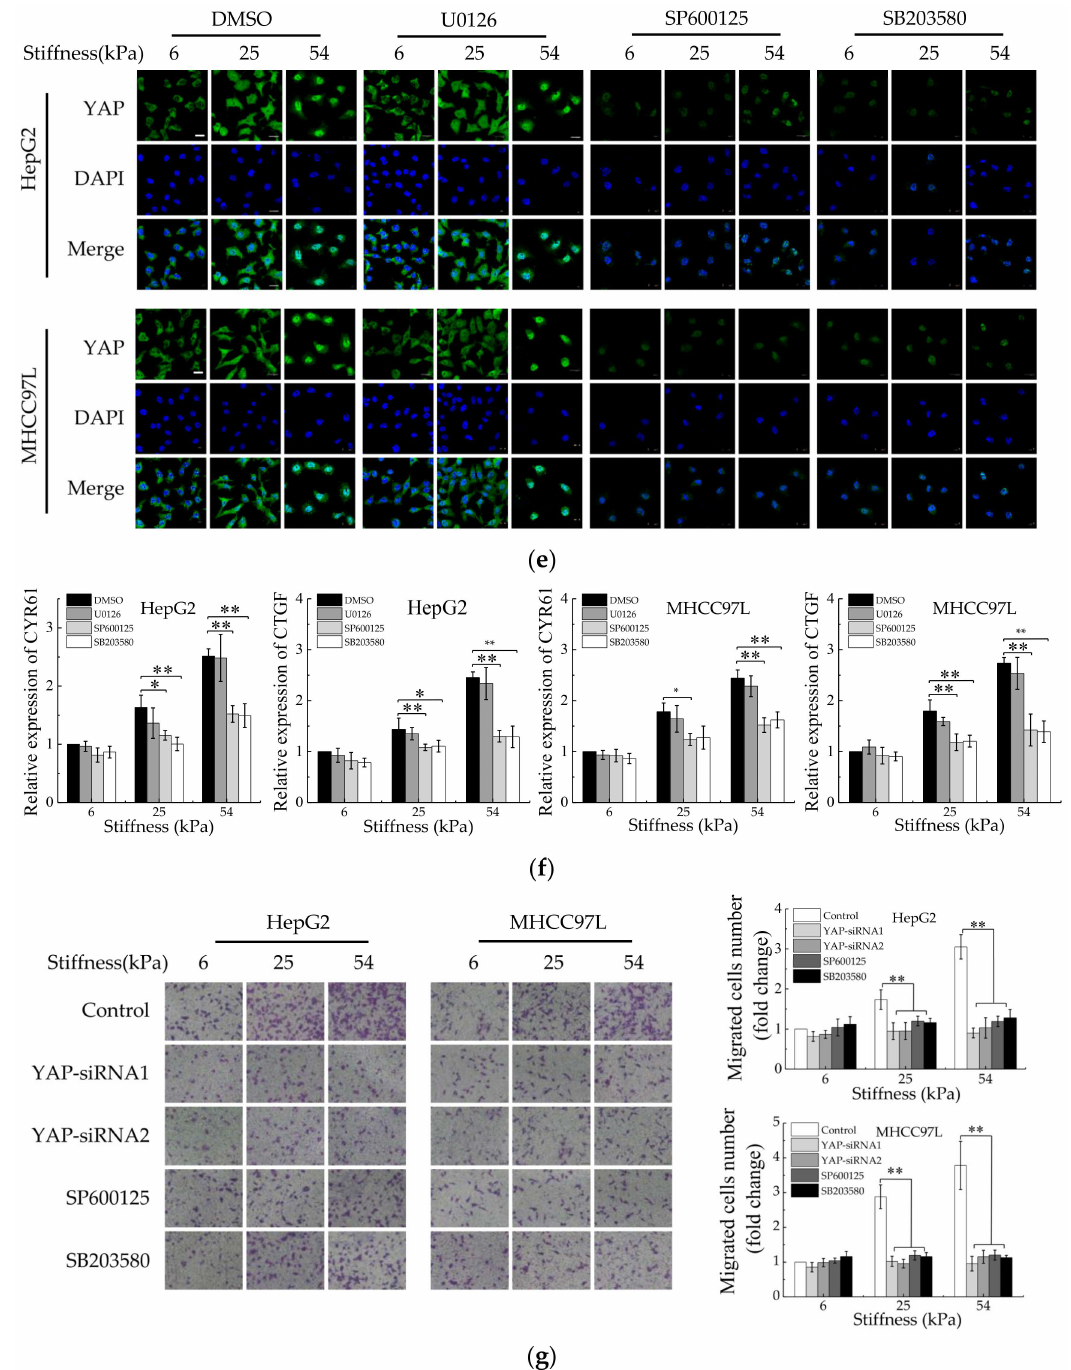
Figure 6. JNK and p38 MAPK signaling regulate sti ff er ECM-induced YAP activation. ( a ) Western blot analysis of the indicated proteins in HepG2 and MHCC97L cells cultured on di ff erent sti ff ness of hydrogels for 48 h. ( b,c,d ) Western blot analysis of the indicated proteins in HepG2 and MHCC97L cells treated with U0126 (10 µ M), SP600125 (20 µ M), SP600125 (10 µ M) or vehicle. ( e ) Confocal immunofluorescence images of YAP in HepG2 and MHCC97L cells after treated with U0126, SP600125, SP600125 or vehicle (Scale bar: 25 µ m). ( f ) qRT-PCR analysis of indicated genes mRNA levels in HepG2 and MHCC97L cells after treated with U0126, SP600125, SP600125 or vehicle ( n = 3, * p < 0.05, ** p < 0.01). ( g ) Transwell assay analysis of HepG2 and MHCC97L cells migration after indicated treatment ( n = 3, * p < 0.05, ** p <